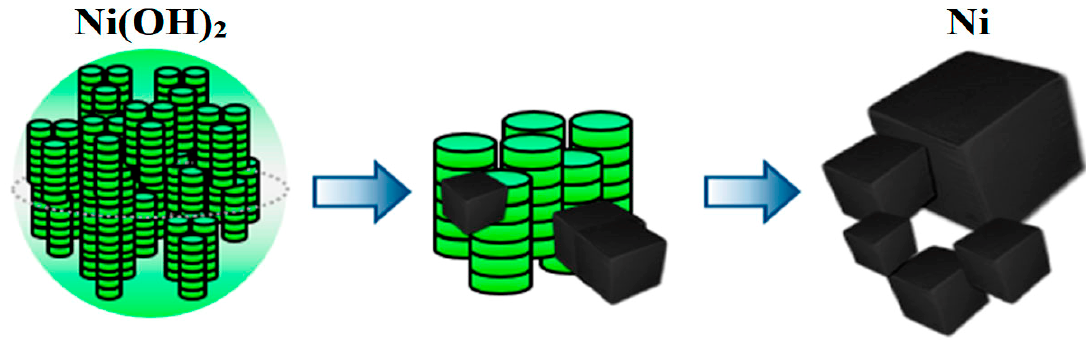
Figure 12. Scheme of metallic nickel formation from its hydroxide.